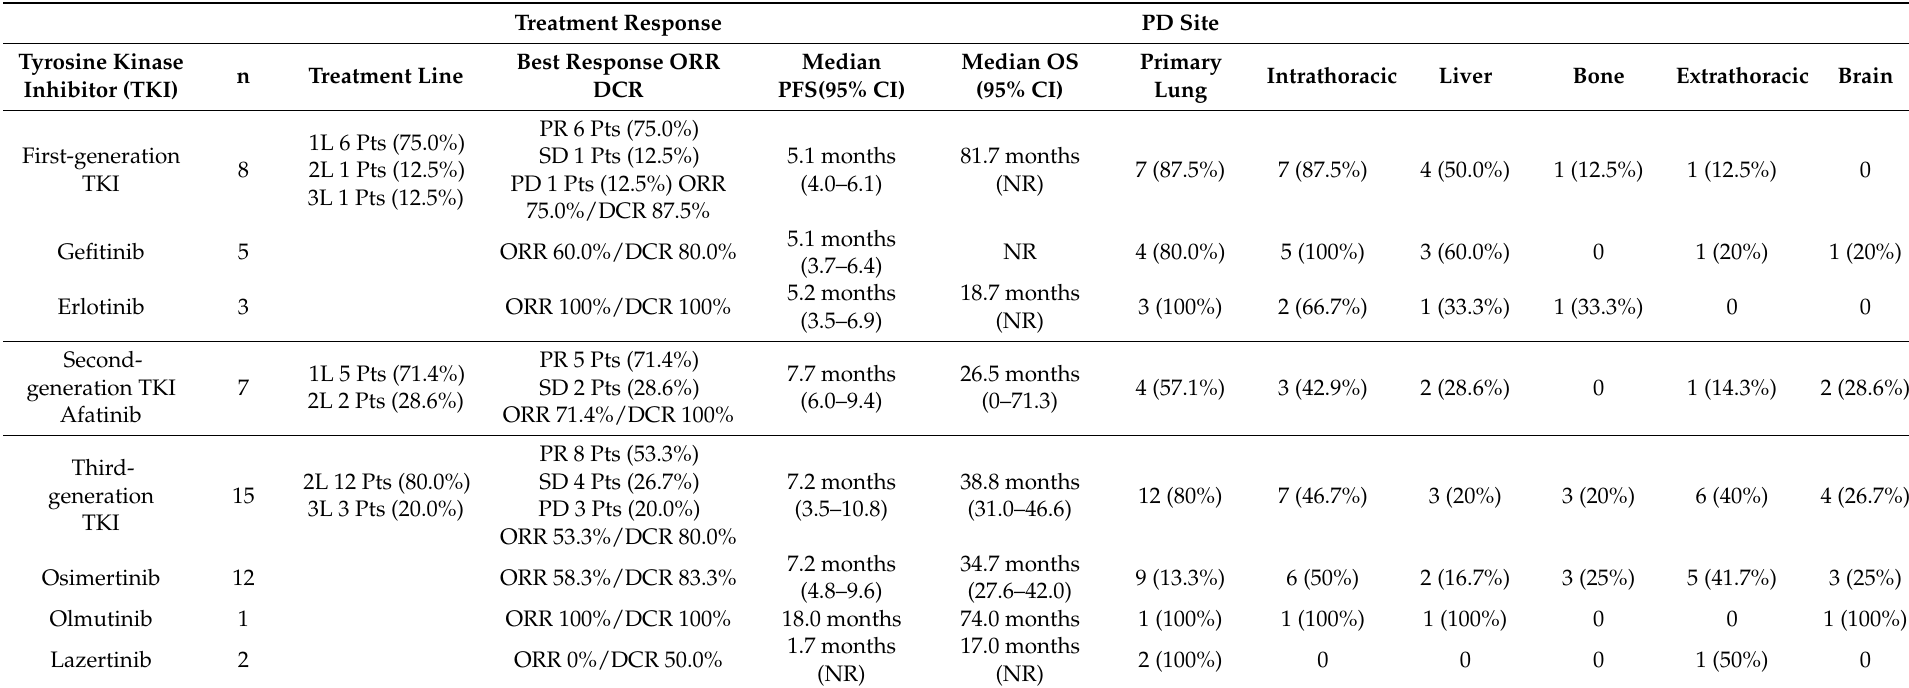
Table 3. Overall response based on latest TKIs of MET-positive patients ( N =